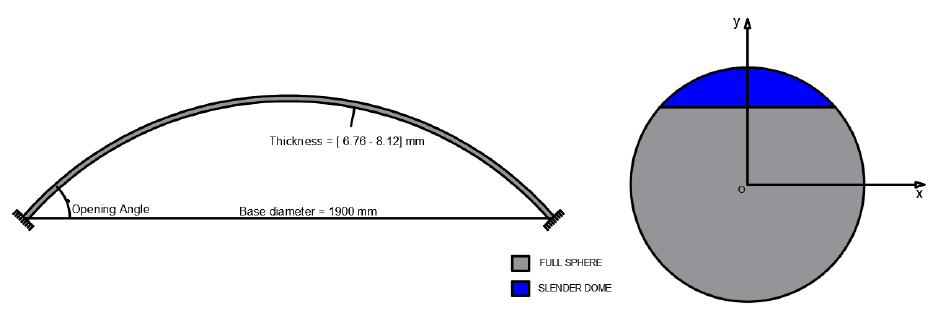
Figure 6. Geometry of the slender spherical domes. The origin of the reference frame is the center of the sphere, and its radius was in the range of 2428–2560